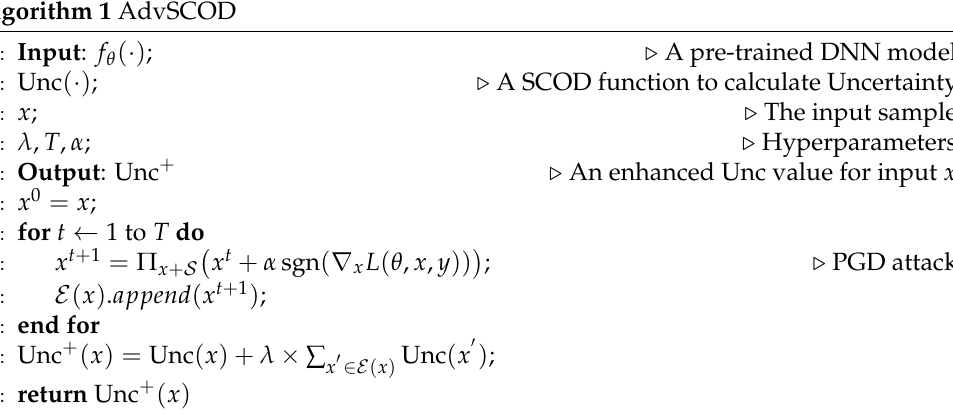
Figure 1. Demonstration of the AdvSCOD framework. Algorithm 1